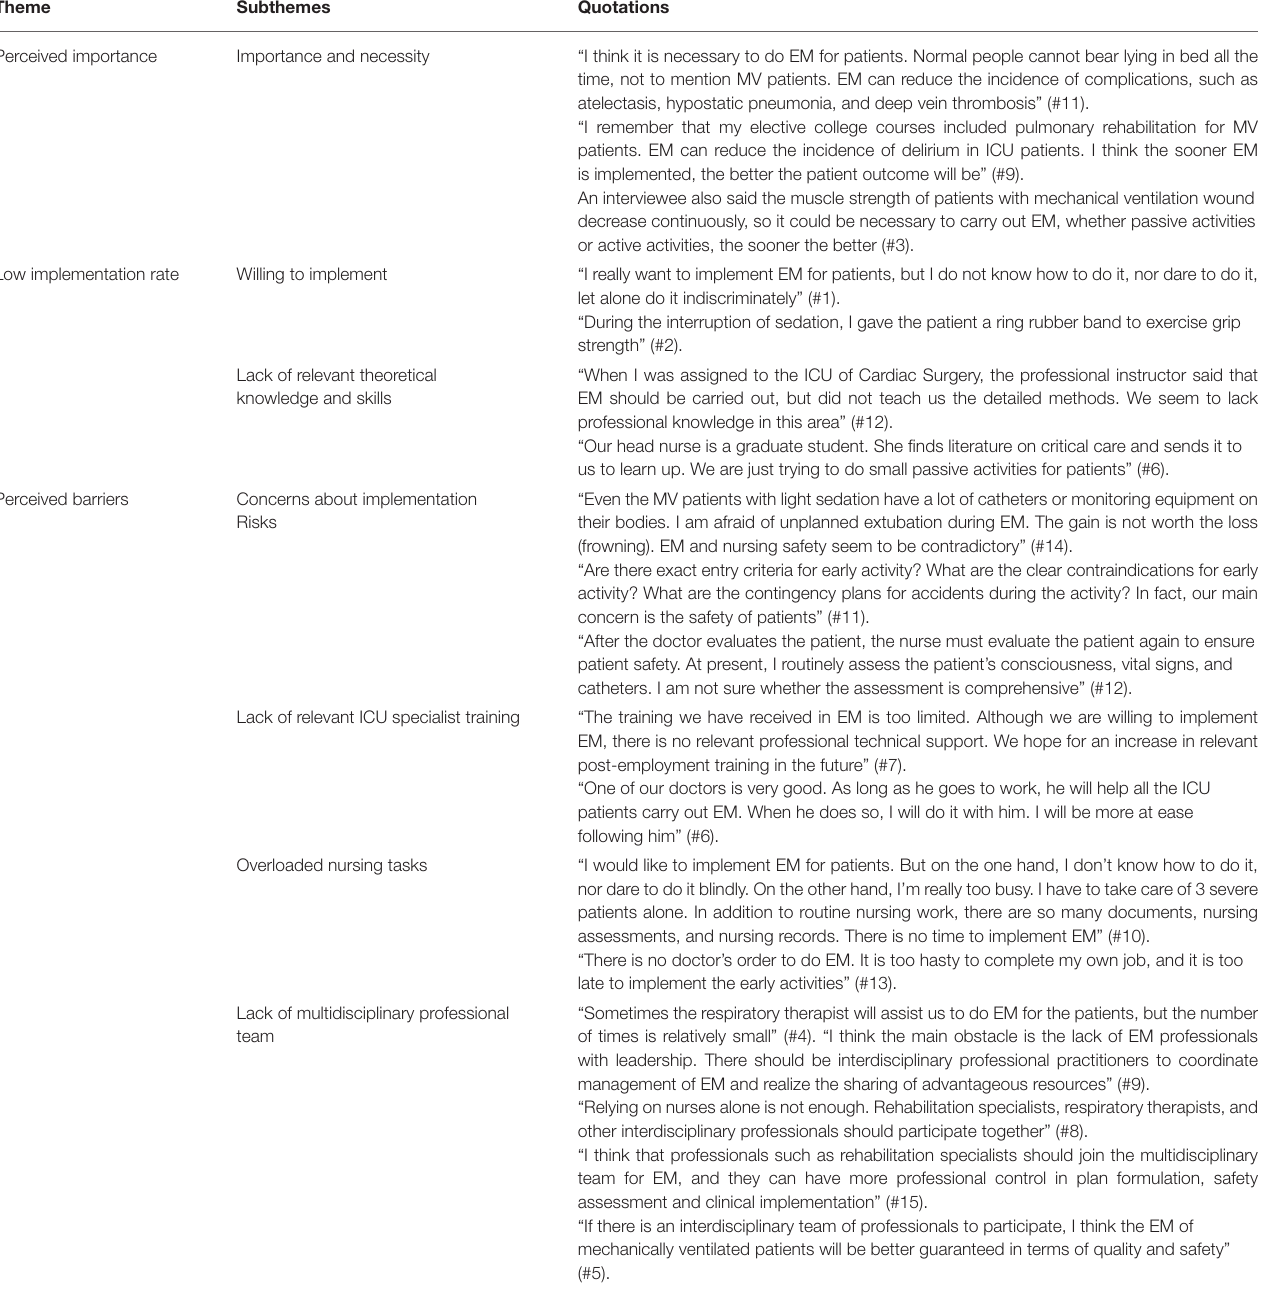
TABLE 4 | Overview of themes and subthemes and supporting